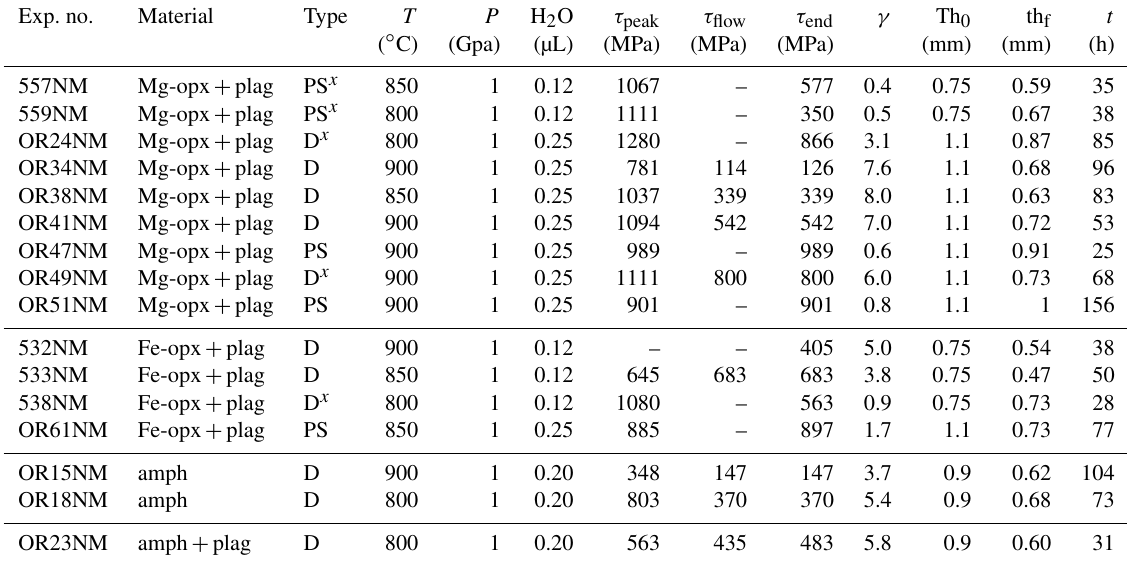
Table 2. List of experiments and experimental conditions. PS: peak stress, D: deformed samples to varying amounts of shear strain. A cross is added to the samples for which the forcing blocks started to slip at the sample interface. τ peak : differential stress at peak, τ flow : steady-state differential stress, τ end : differential stress at end of experiment, γ : shear strain, th 0 : thickness initial of the shear zone, th f : final shear zone thickness, t : time before hit